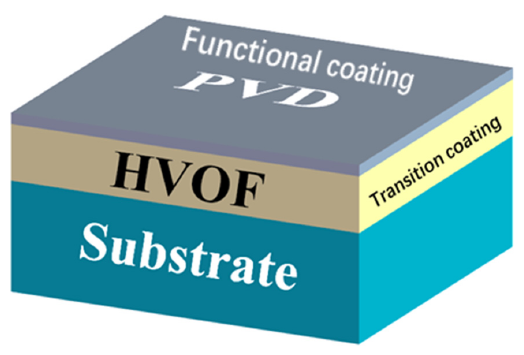
Figure 3. Structure of HVOF-PVD duplex coating.